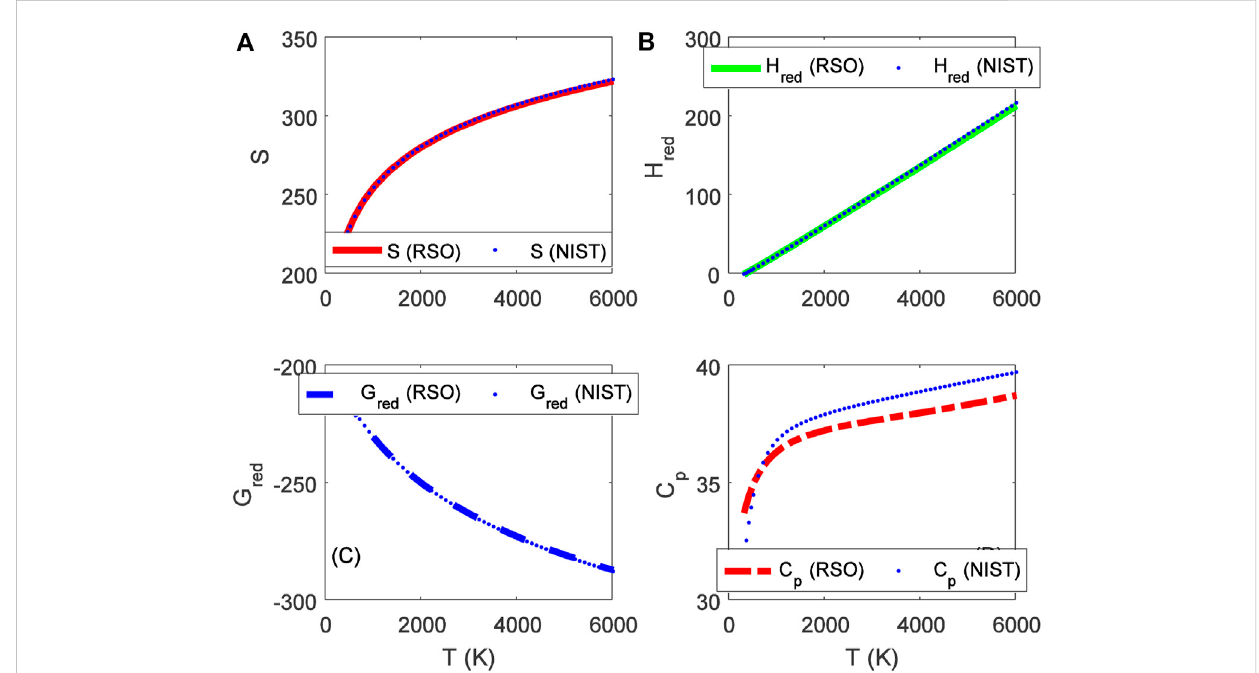
FIGURE 3 Variationof (A) molarentropy(Jmol − 1 K − 1 ), (B) reducedenthalpy (kJmol − 1 ), (C) reducedGibbsfreeenergy(J mol − 1 K − 1 ),and (D) isobaric speci fi cheat capacity as a function of temperature for the ground state BCl (X 1 Σ + ) molecule.